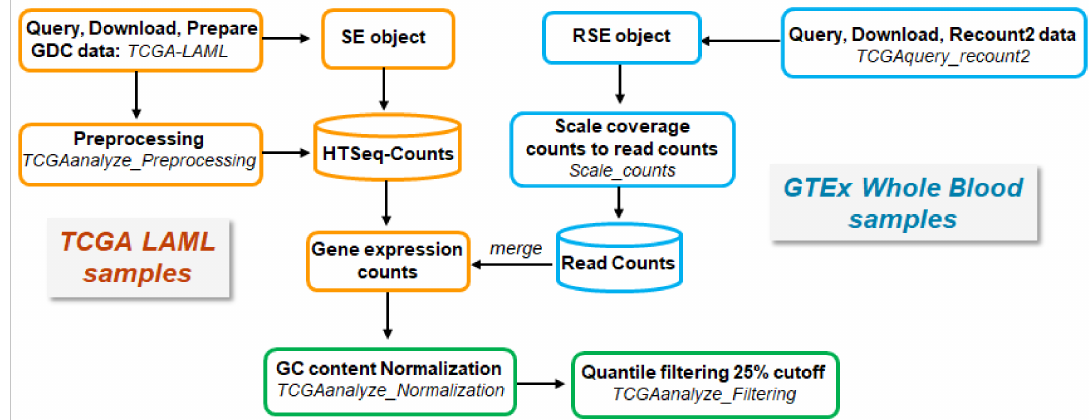
Figure 6. Schematic workflow of retrieving, processing, and merging TCGA and GTEx